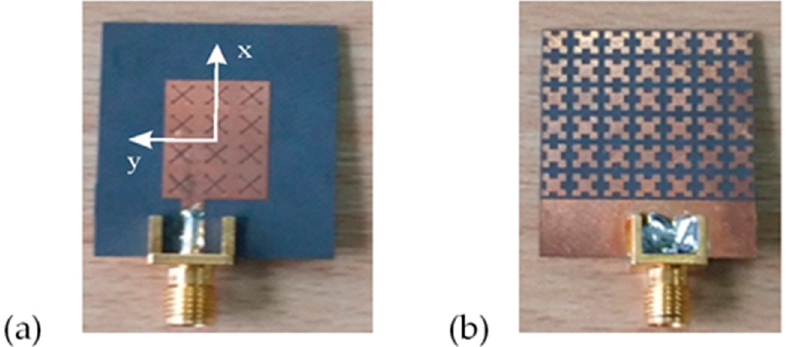
Figure 6. Picture of the fabricated antenna. ( a ) One side of the antenna ( b ) another side of the antenna.